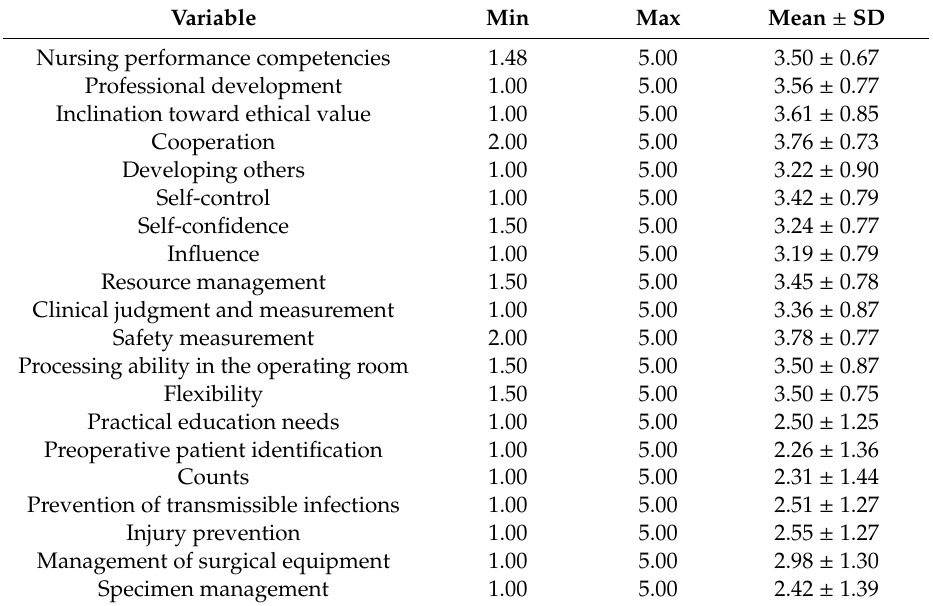
Table 1. Levels of nursing performance competencies and practical education needs ( n =